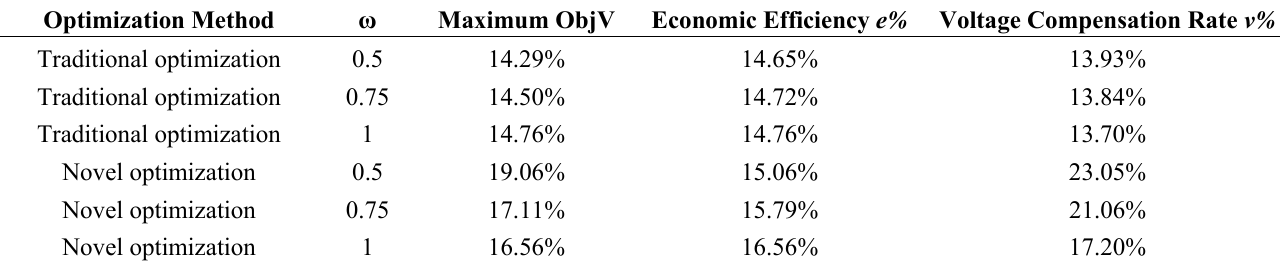
Figure 17. Simulation comparisons of two optimization methods . Table 7. Maximum ObjV obtained by different optimization method .